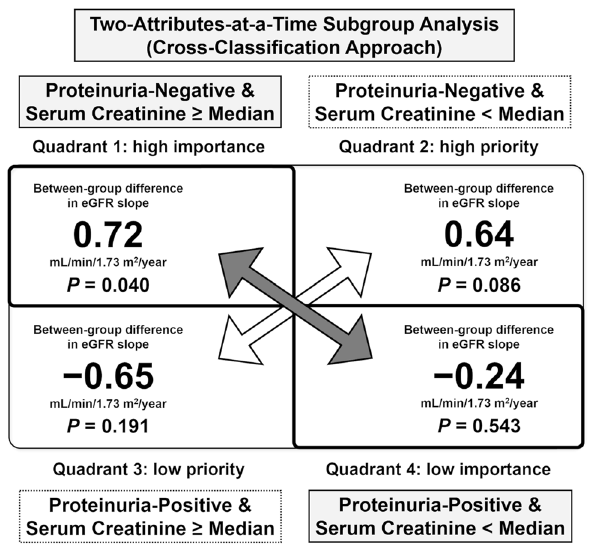
Figure 2. Cross-classification approach (importance grid analysis) for attributes regarding between-group differences in the estimated glomerular filtration rate (eGFR) slope. Quadrant 1: without proteinuria and serum creatinine level ≥ median; Quadrant 2: without proteinuria and serum creatinine level < median; Quadrant 3: with proteinuria and serum creatinine level ≥ median; Quadrant 4: with proteinuria and serum creatinine level < median. Quadrants 1 and 4 can be used to discriminate the importance of the absence of proteinuria and a serum creatinine level < median for the efficacy of febuxostat in patients with chronic kidney disease. As the between-group difference in the eGFR slope in quadrant 1 was significant for the efficacy of febuxostat, despite the fact that the serum creatinine level was ≥ median, the absence of proteinuria is a more important attribute compared to the serum creatinine level being < median. Accordingly, the absence of proteinuria is an attribute affecting the efficacy of febuxostat in patients with chronic kidney disease (all values were derived from Table